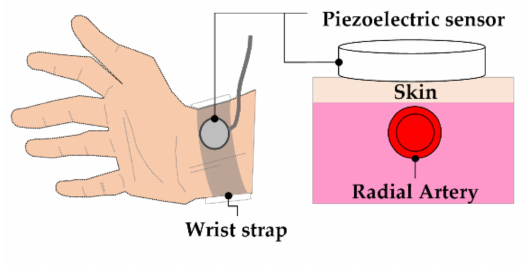
Figure 4. Piezoelectric sensor measurement